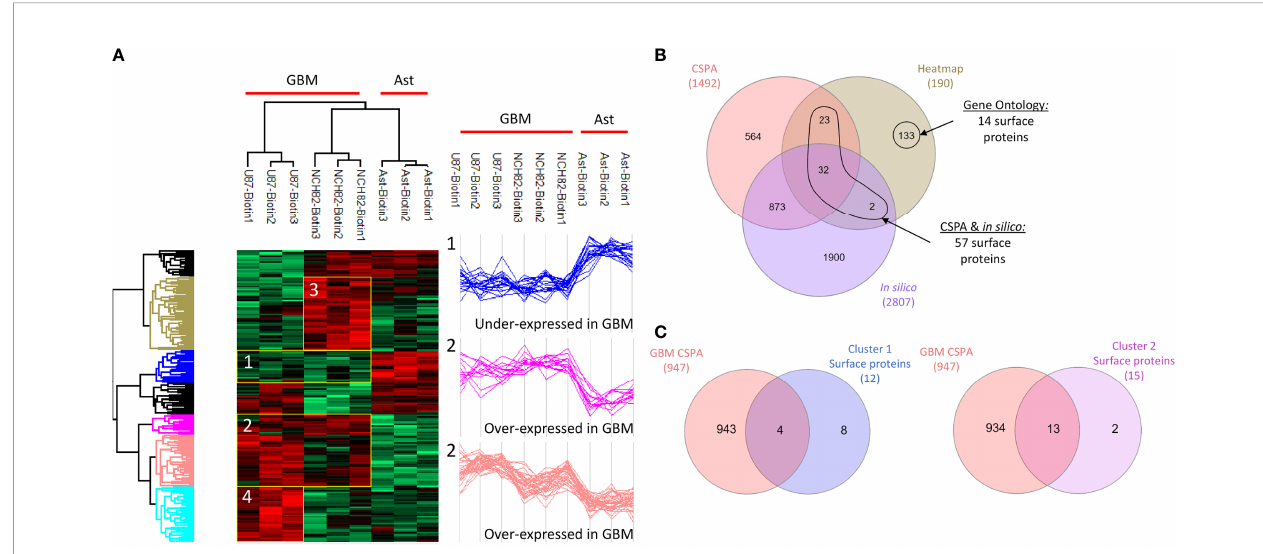
FIGURE 1 | Healthy astrocyte cell line, U87 and NCH82 GBM cell lines were biotinylated and lysed. Biotinylated surface proteins were puri fi ed on streptavidin beads, digested, and analyzed with LC-MS/MS. MaxQuant and Perseus software were used for the statistical analysis. (A) A heatmap was generated to show proteins with expression signi fi cantly different between cell lines. Two clusters are highlighted (1 and 2). (B) Venn diagram was performed between the 190 proteins of the heatmap and the surface proteins from CSPA and in silico CSPA databases to identify 57 surface proteins. Analysis of Gene Ontology of the different proteins allowed the discovery of 14 additional surface proteins. (C) Proteins from cluster 1 and cluster 2 were compared to surface proteins described for different GBM cell lines in CSPA (GBM